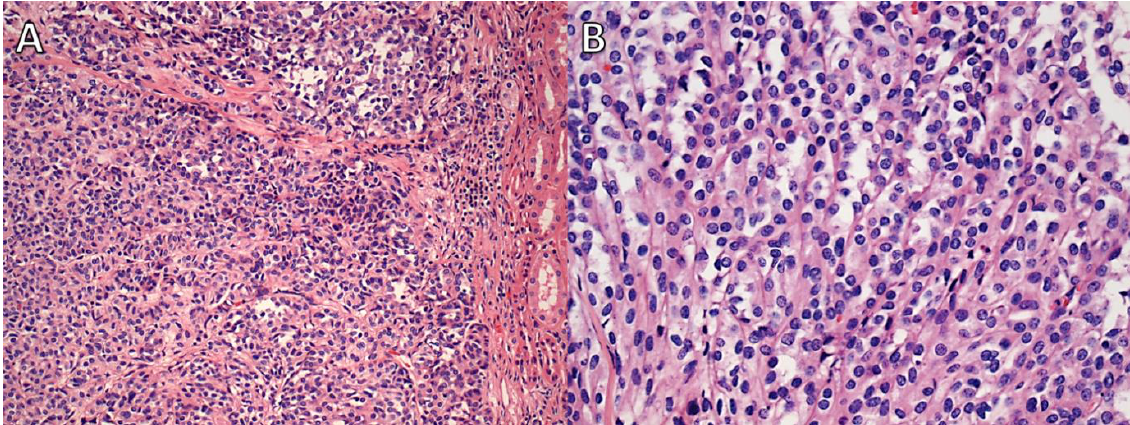
Figure 6. Case 2: A . Low-power and ( B ) high-power fields showing mucinous tubular and spindle cell carcinoma.